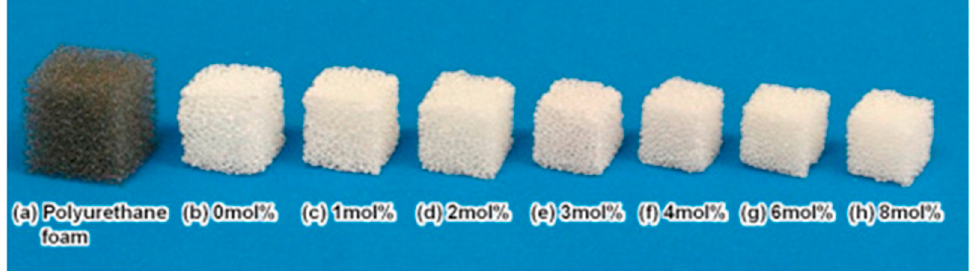
Figure 8. Typical macroscopic structure of: ( a ) the polyurethane foam template and ( b – h ) TCP foams prepared with calcium phosphate slurries containing different amounts of MgO. Reprinted from [122] with permission from Elsevier.